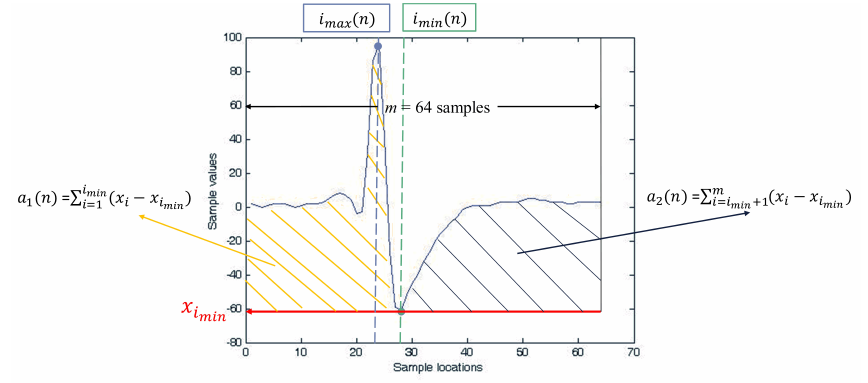
Figure 4. An example of the feature extraction computation of the PDAC algorithm. The a 1 ( n ) and a 2 ( n ) are the areas of the shaded regions shown in the figure. After a 1 ( n ) and a 2 ( n ) are obtained, the features f 1 ( n ) and f 2 ( n ) are obtained by Equation (8).